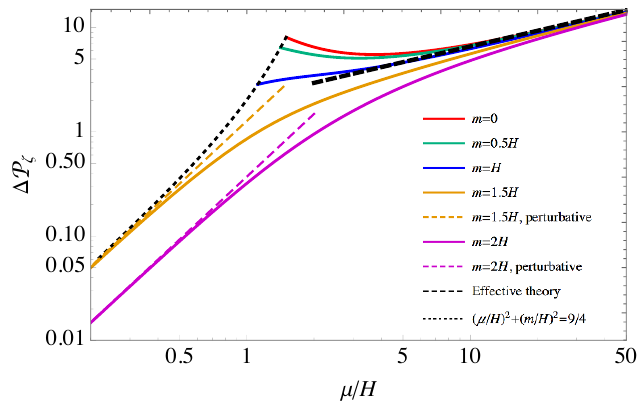
Figure 1 . The correction of the power spectrum of curvature perturbation (cid:1) P (cid:16) in units of ( H 4 = _ (cid:30) 2 )(1 = 2 k 3 ) due to the mixing with the new (cid:12)eld s . The red, blue, green, orange and ma- 0 genta curves are for m = 0 ; 0 : 5 H; H; 1 : 5 H and 2 H . The black dashed curve shows the result from the e(cid:11)ective theory and the colored dashed lines are perturbation